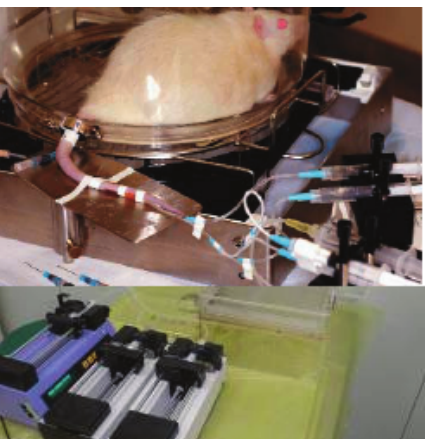
Figure 1: Tracer perfusion platform in the rat. Catheters were inserted into the tail artery and vein. This procedure used small incisions and enabled the rats to be kept conscious and relaxed throughout the experiment. It was constantly infused through the i.v. infusion line driven by a Harvard mini-infusion pump (Harvard Apparatus, Holliston, MA, USA) for 75 min (basal period). The infusion rates were 0.5 𝜇 Ci/kg/min (3- 3 H-glucose) and 0.84 𝜇 mol/kg/min (U- 13 C-glycerol). Blood was sampled prior to infusion of tracer and at 65, 70, and 75 min. Subsequently, while the 3- 3 H-glucose infusion continued, a primed and continuous infusion of recombinant human insulin 5 mIu/kg/min was initiated for another 90min. The plasma glucose concentration was kept constant at the basal level by monitoring the plasma glucose every 10 minutes and empirically adjusting the infusion rate of a 50% glucose solution. Twenty minutes before the end of the chase period, 1 𝜇 Ci of 2-deoxy-D- 14 C-glucose was injected through the i.v. infusion line to enable measurement of tissue glucose uptake. During the final 10 minutes, 3 more blood samples were collected at 5-minute